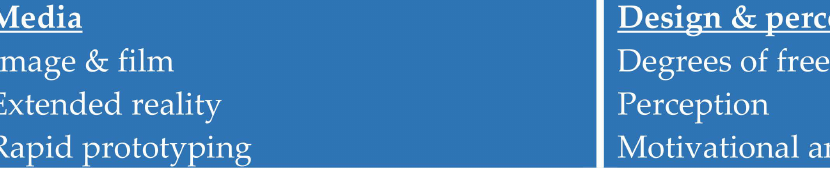
Figure 15. Chapter